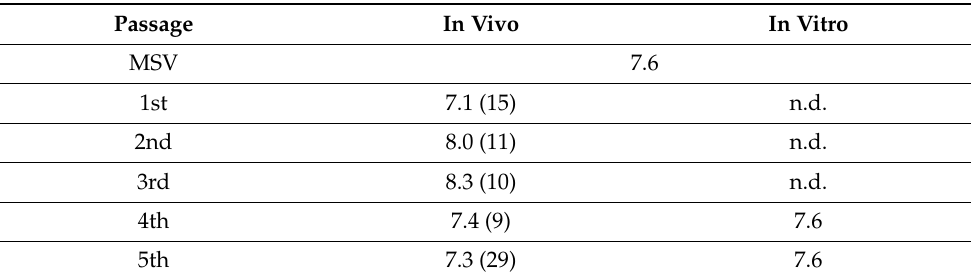
Table 3. Titer ( 10 log FFU/mL) of the original material (MSV) and the different serial in vivo (SMB) and in vitro (BHK21 Clone 13 cells) passages; the number of SMBs used per passage is listed in parenthesis; n.d.—not